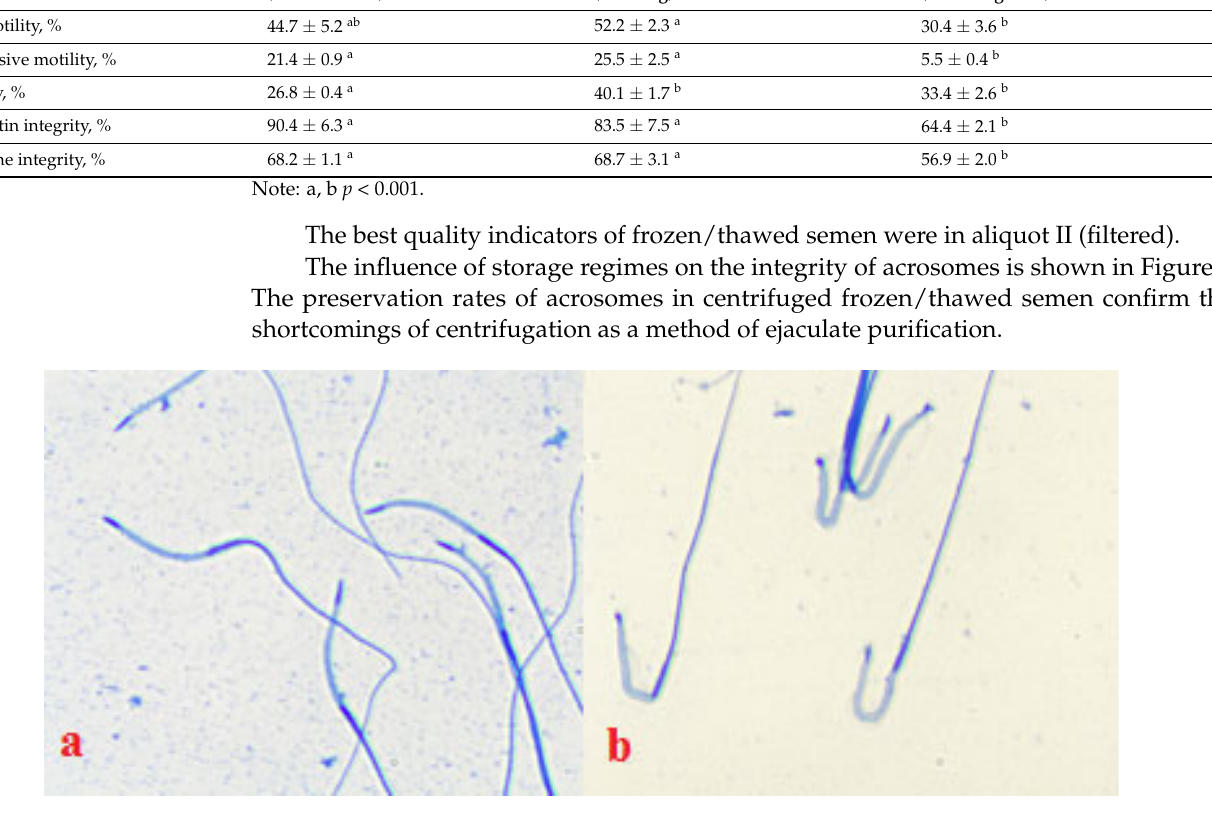
Table 3. The results of the assessment of frozen/thawed semen under the influence of technological factors (Mean ± SEM).